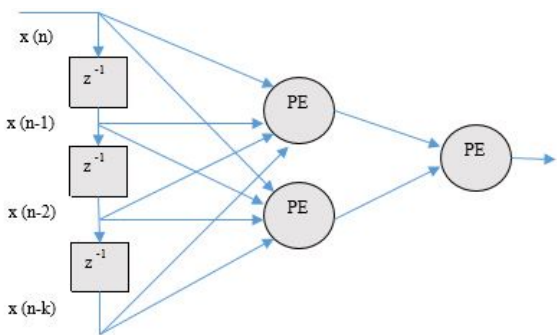
Figure 1. Focused time-delayed neural network (TDNN) with one hidden layer and tap delay line of k + 1 taps.